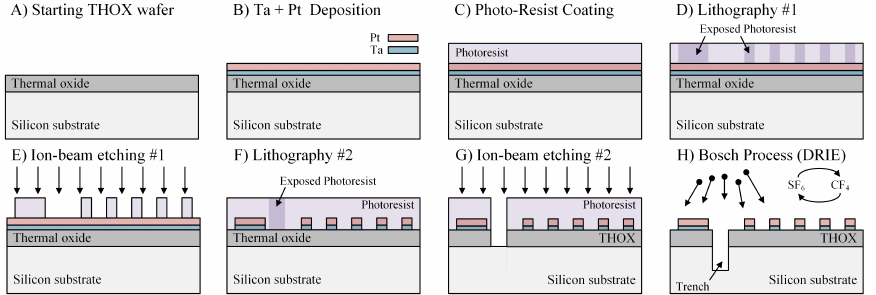
Figure 3. Steps required for fabrication of trenched demonstrators. ( A ) Starting point are six inch, thermal oxide substrates. ( B ) Physical vapor deposition of the functional metallic layer. ( C ) Photo-resist spin-coating and preparation for lithography. ( D ) First lithographic step for definition of heaters and thermometer structures. ( E ) First ion-beam etching step for removal of uncovered metal areas. ( F ) Second